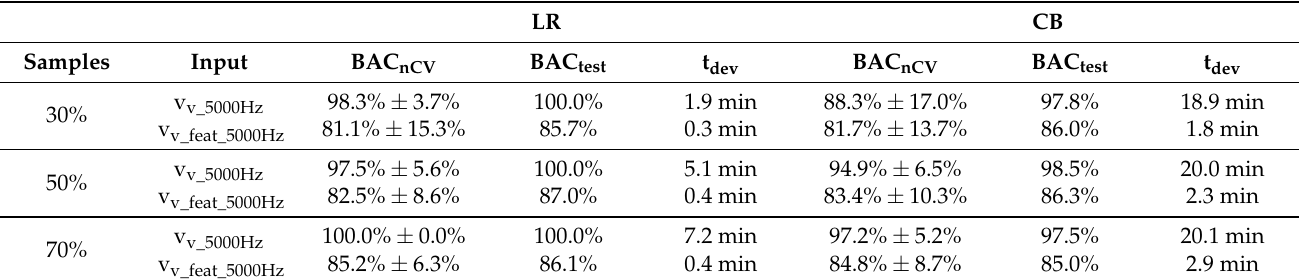
Table 5. The BAC of classifiers trained using FFT of simulated vibration velocity v_v (v v_5000Hz ) or features computed from the FFT data (v v_feat_5000Hz ). The experiment was repeated with 30%, 50%, and 70% of samples in the training dataset. LR